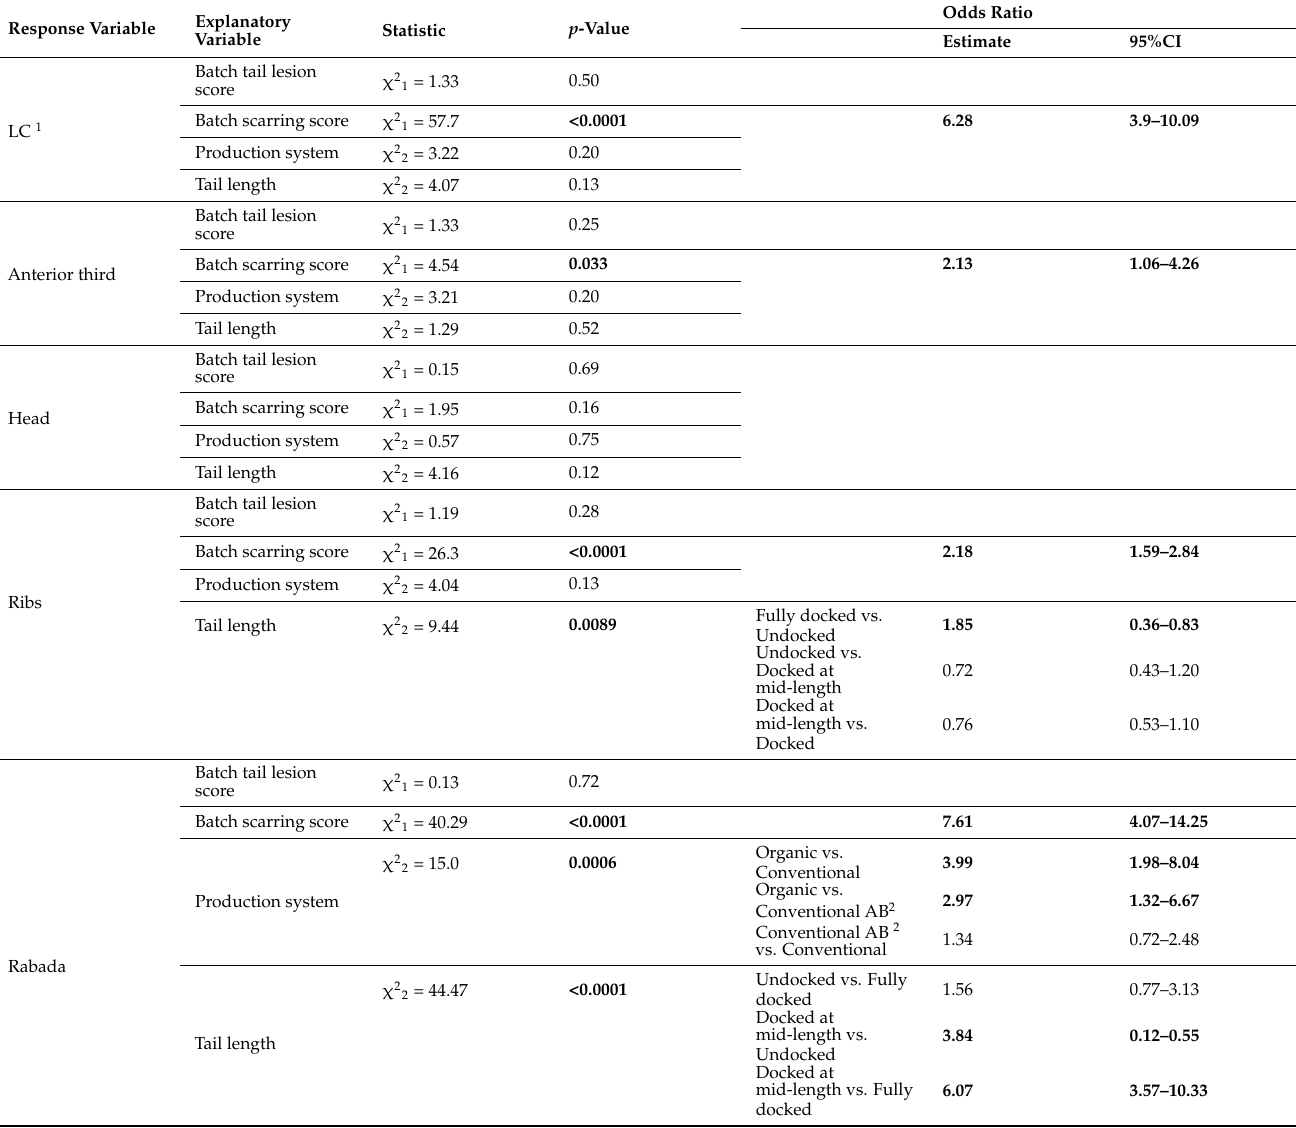
Table 5. Logistic regression model exploring batch-level variation in local condemnation probability and parts condemned within pigs’ batches ( n = 73) at the slaughterhouse. For significant variables, odds ratio estimates (OR) and their 95% confidence interval (CI) are presented, with estimates for continuous scores calculated for a 0.5-unit increase. Significant p -values and ORs are highlighted in